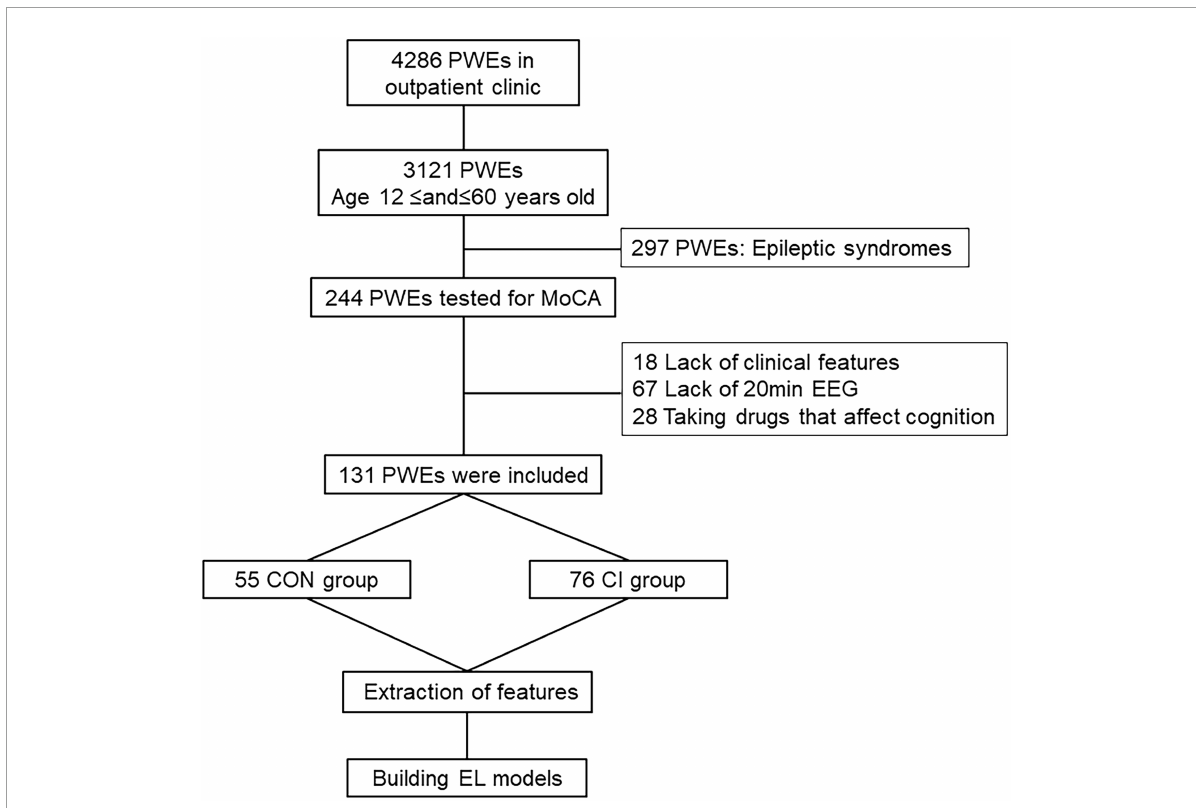
FIGURE1 Flow chart. PWEs, patients with epilepsy; MoCA, Montreal Cognitive Assessment; EEG, electroencephalogram; CI, cognitive impairment; CON, cognitively normal; EL, ensemble learning.